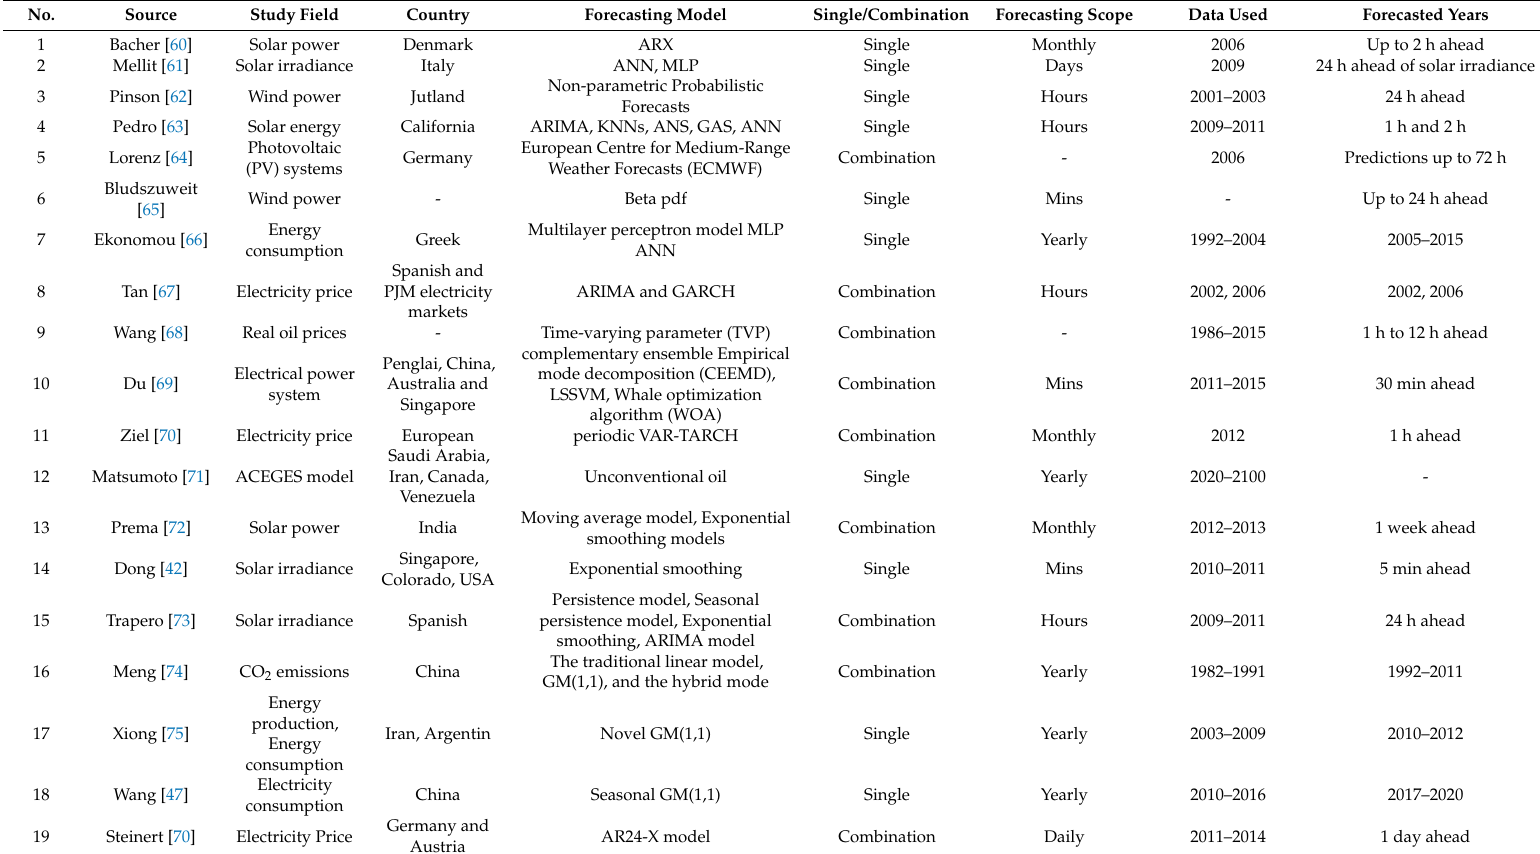
Table 2. Review of energy forecasting